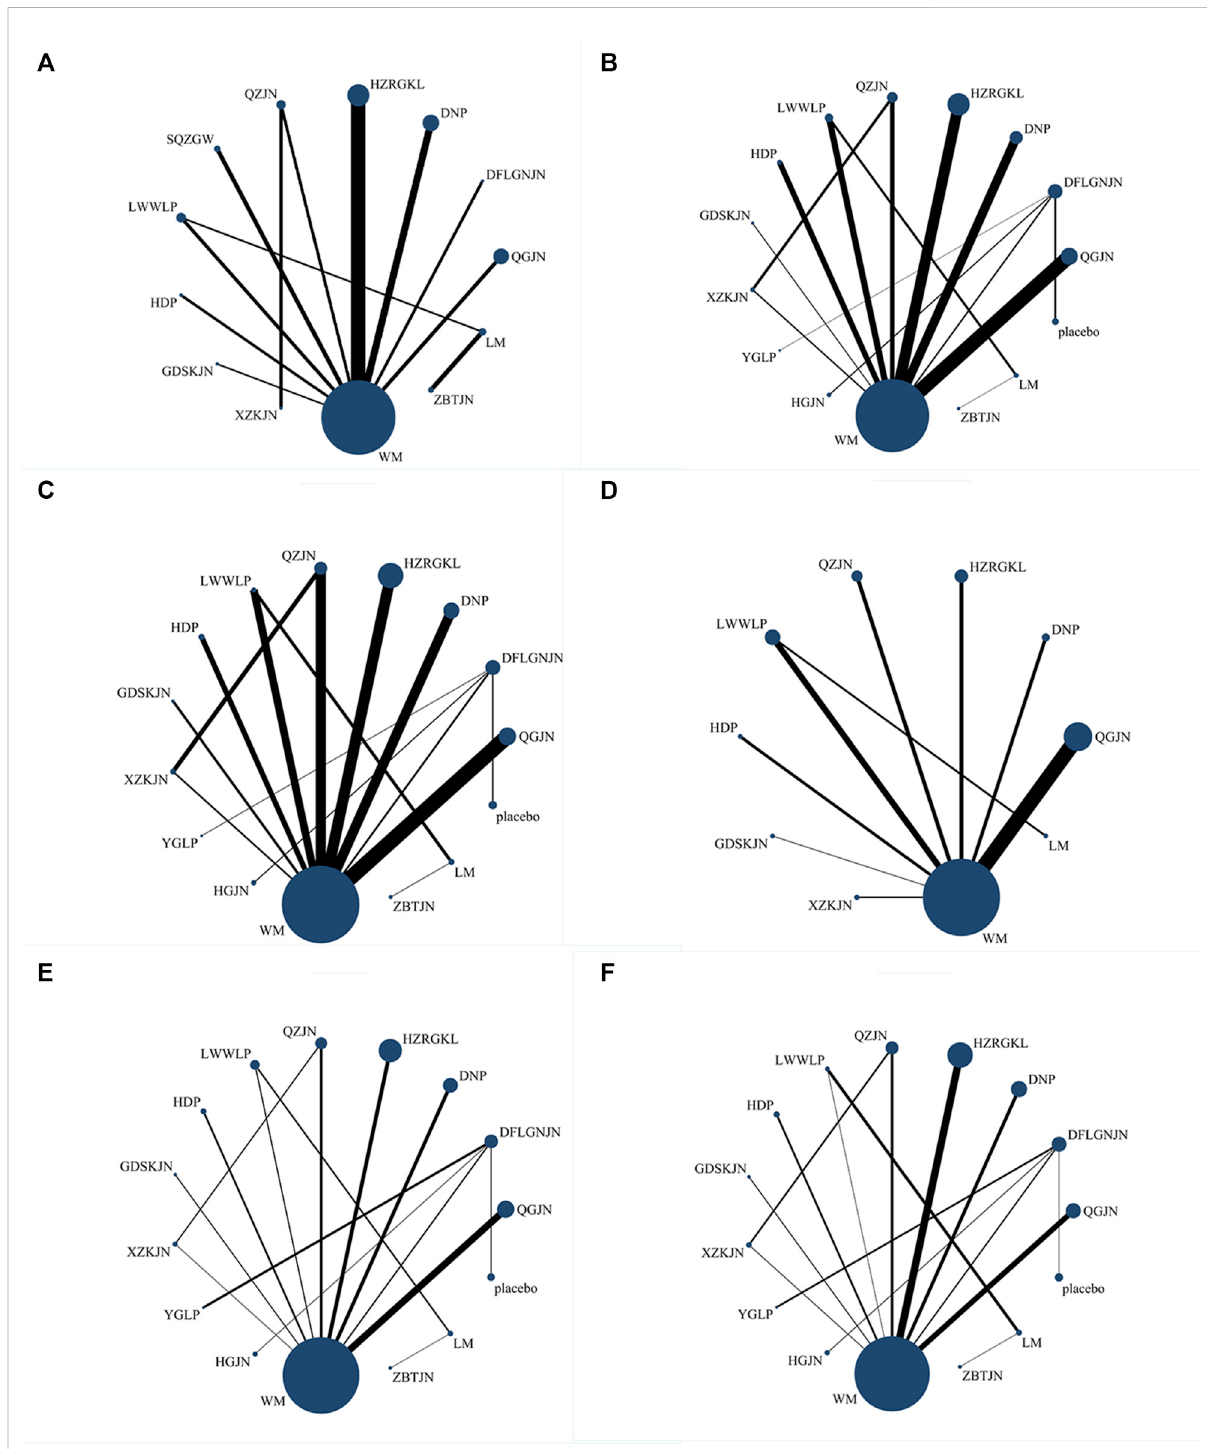
FIGURE 3 Network evidence plots (A) Clinical ef fi ciency rate (B) ALT (C) AST (D) GGT (E) TG (F) TC; WM, Western medicine; QGJN, Qianggan capsule; DFLGNJN, Dangfei Liganning capsule; DNP, Danning tablet; HZRGKL, Huazhi Rougan granule; QZJN, Qiaozhi capsule; SQZGW, Sanqi Zhigan pill; LWWLP, Liuwei Wuling tablets; HDP, Hedan tablet; GDSKJN, Gandan Shukang capsule; XZKJN, Xuezhikang capsule; YGLP, Yiganling tablet; HGJN, Hugan capsule; ZBTJN, Zhibitai capsule; LM, lifestyle modi fi